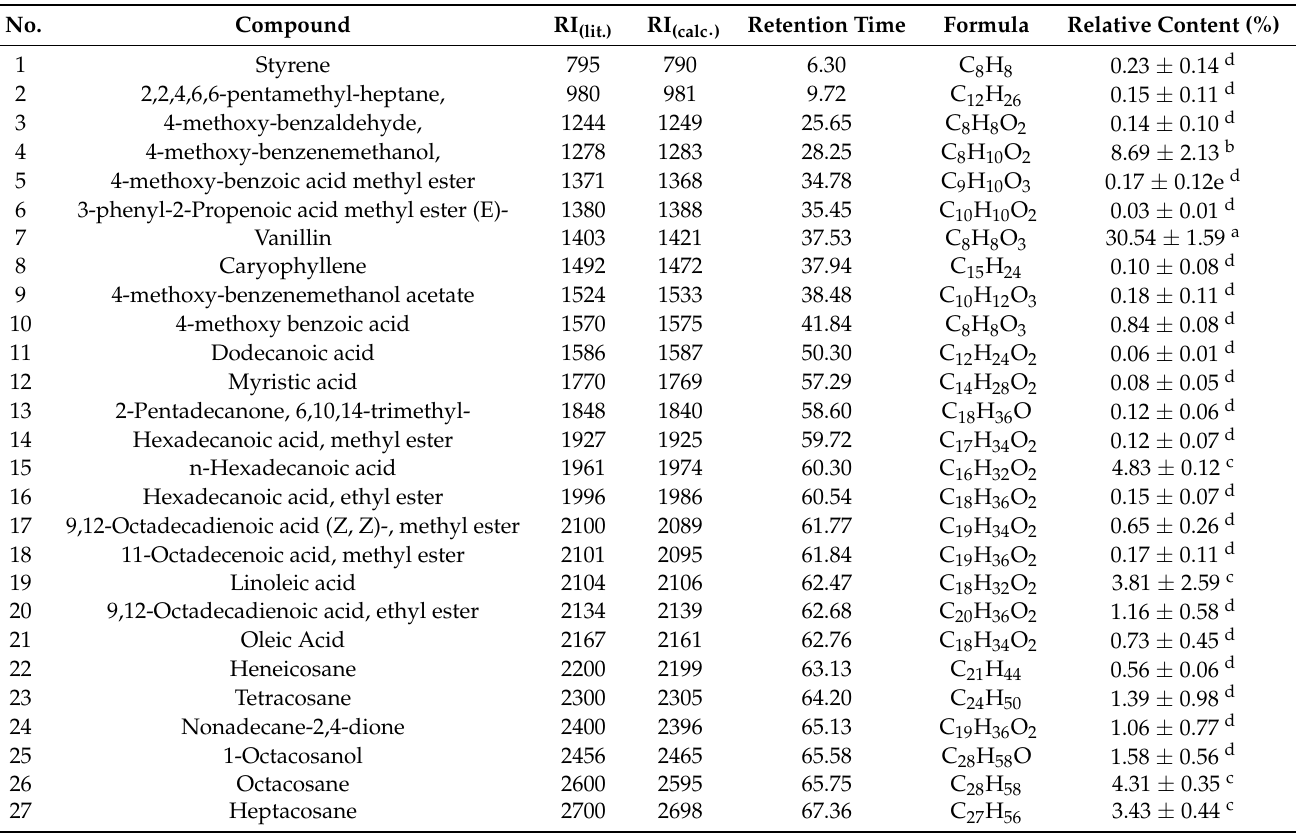
Table 2. The chemical composition of vanilla essential oil.